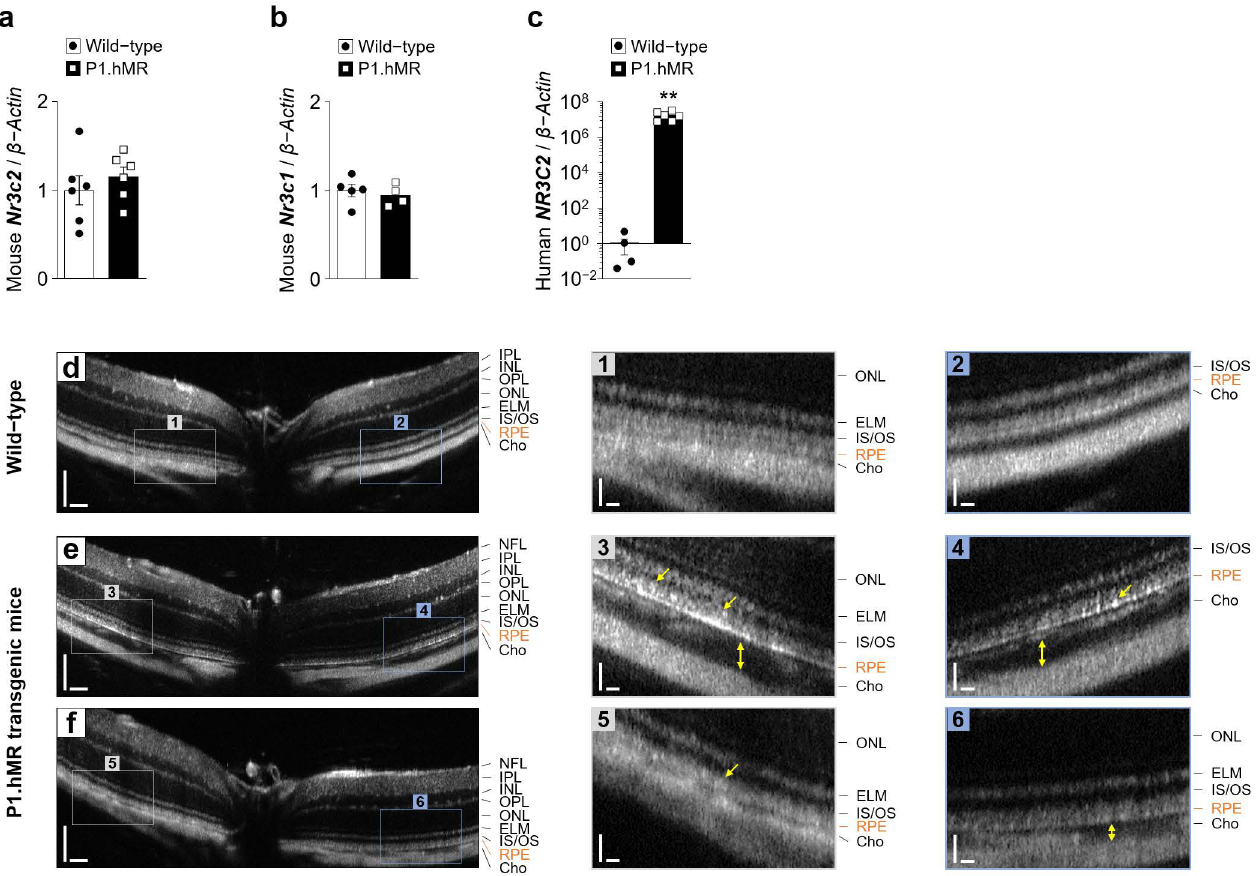
Figure 10. Clinical phenotype of P1.hMR transgenic mice. ( a – c ) Quantification by RT-qPCR of the mouse Nr3c2 encoding MR ( a ), the mouse Nr3c1 encoding GR ( b ) and the human Nr3c2 ( c ) mRNA to β -Actin in RPE/choroid complexes ( n = 4–6 eyes per condition) from wild-type animals and mice overexpressing a human MR P1.hMR transgene. Values are means ± SEM. Unpaired t -test with Welch’s correction. ** p < 0.01. ( d – f ) Representative in vivo MICRON III image-guided optical coherence tomography images of B-scans passing through the optic nerve of retina from wild-type ( d ) or transgenic P1.hMR ( e , f ) mice showing increased choroidal thickness (yellow double arrows) and irregular and hyper-reflective signal at the level of the RPE (yellow arrows). Scale bar: 100 µ m ( d – f ) and 25 µ m (insets 1 – 6 ). NFL, nerve fiber layer; IPL, inner plexiform layer; INL, inner nuclear layer; OPL, outer plexiform layer, ONL, outer nuclear layer; ELM, external limiting membrane; IS, inner segment; OS, outer segment; RPE, retinal pigment epithelium; Cho,